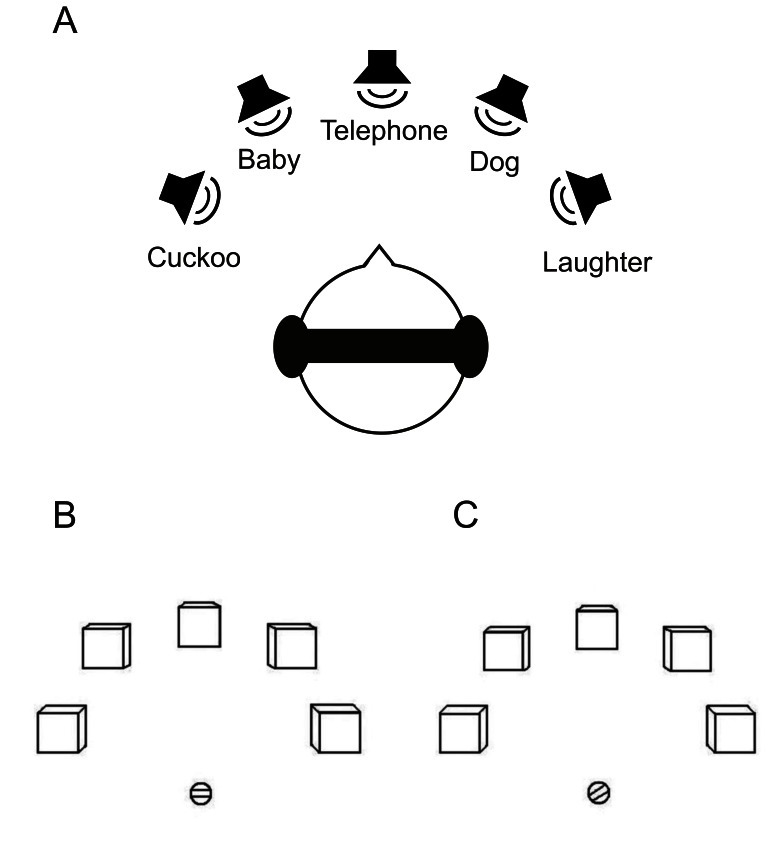
Auditory and visual stimuli.(A) Example of one virtual auditory scene used for the “cocktail” and “passive” conditions. Each sound was presented as coming from a different location. (B, C) Visual stimuli. Each box represented a sound source (“single” and “cocktail” conditions) or from left to right the total number of sounds presented in a sequence of sounds (“sequence” condition). Subjects were instructed to perform a saccade as the response in each trial. In the “active” tasks (i.e., “single”, “cocktail”, and “sequence” conditions), the slot in the circle, which served as saccade starting point, was presented horizontally (neutral) hence not cueing any particular direction. (B). In the “passive” condition, the saccade direction was cued by the slot in the circle (C).